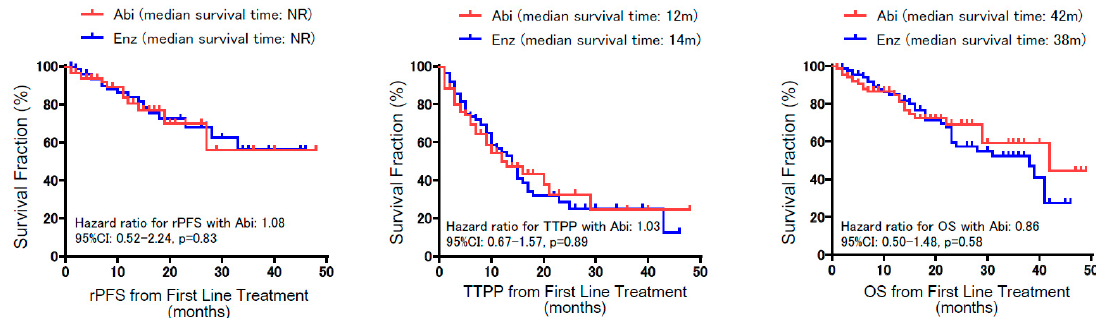
Figure 1. Study design and inclusion criteria of the propensity score-matched analysis in patients newly diagnosed with castration-resistant prostate cancer (CRPC). A 1:1 matching across the two treatment arms was performed using the nearest neighbor method with a 0.2-width caliper of the standard deviation of the logit of the propensity scores.